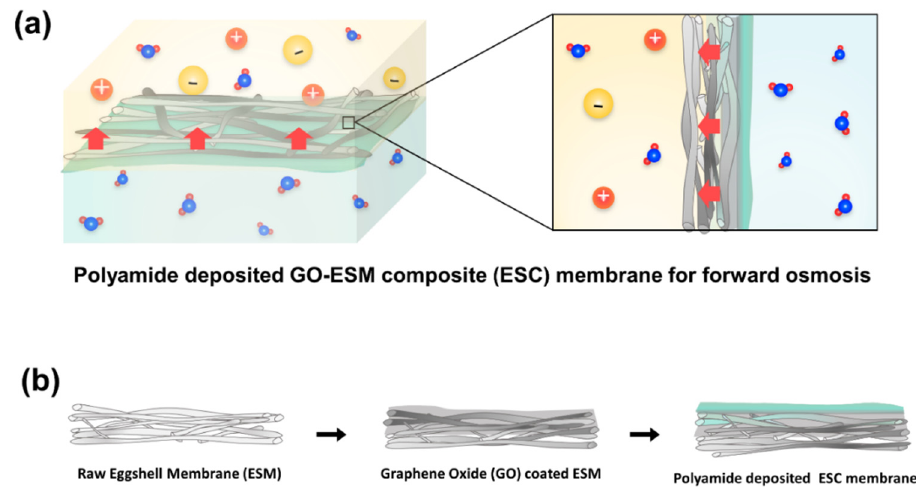
Figure 1. Schematic of ( a ) composite membrane for FO and ( b ) fabrication process.